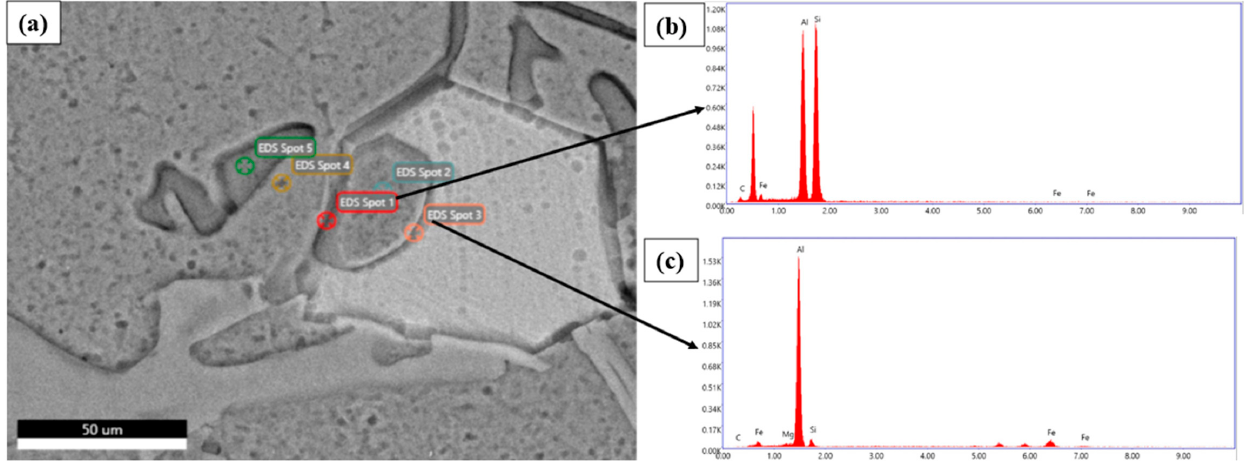
Figure 4. ( a ) SEM-BES morphology of MMC and EDS spectra of ( b ) SiC reinforcement and ( c ) LM6 base matrix.